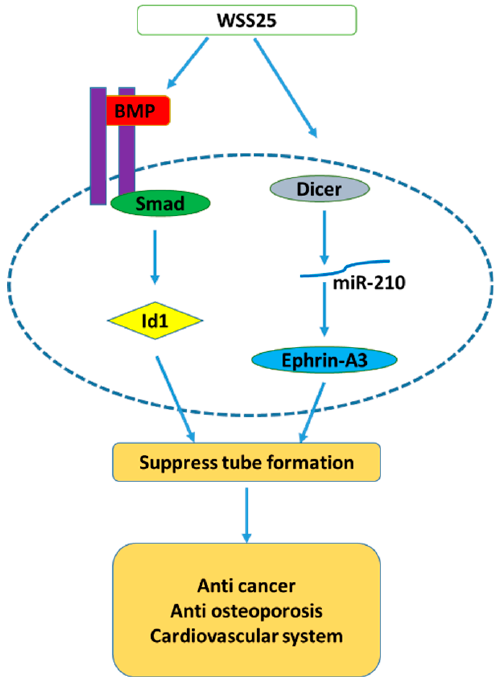
Figure 3. The pathway of tube formation suppression by the sulfated polysaccharides WSS25 from G. elata . It was also reported that WSS25 can interact with BMP-2 in hepatic cancer cells [95]. Meanwhile, BMP-2 plays an important regulatory role in osteoclast and osteoblast cells [98,99]. WSS25 can inhibit bone loss induced by ovariectomy in female mice. This result suggests that WSS25 might be an e ff ective anti-osteoporosis drug for older women